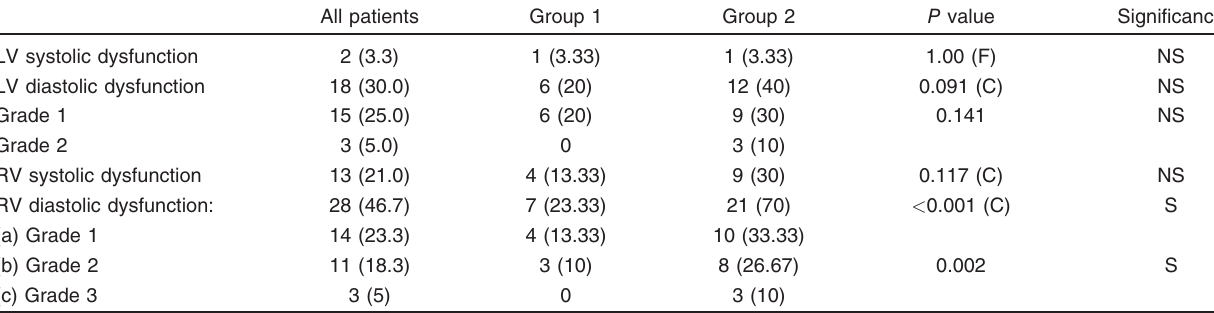
Table 3 Prevalence and grades of left and right ventricular dysfunction All patients Group